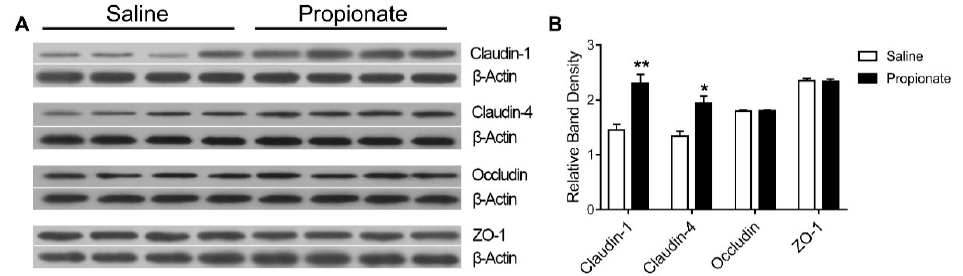
Figure 3. Effect of the cecal infusion of propionate on the expression of tight junction protein expression in the jejunum: ( A ) the bands and ( B ) relative band density.